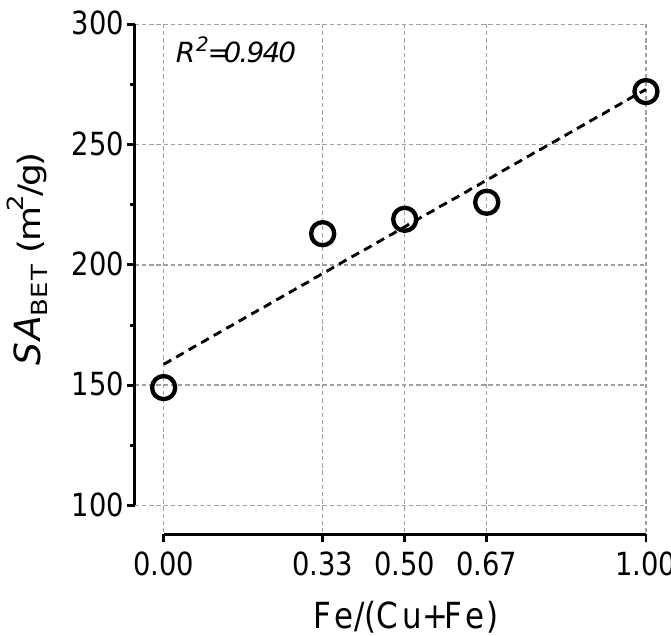
Figure 2. Effect of the Fe/(Cu + Fe) atomic fraction on the surface exposure ( SA BET ). The XRD patterns of the bi-metallic Cu(x)Fe(y)-Si samples after calcination and re- duction are shown in Figure 3.